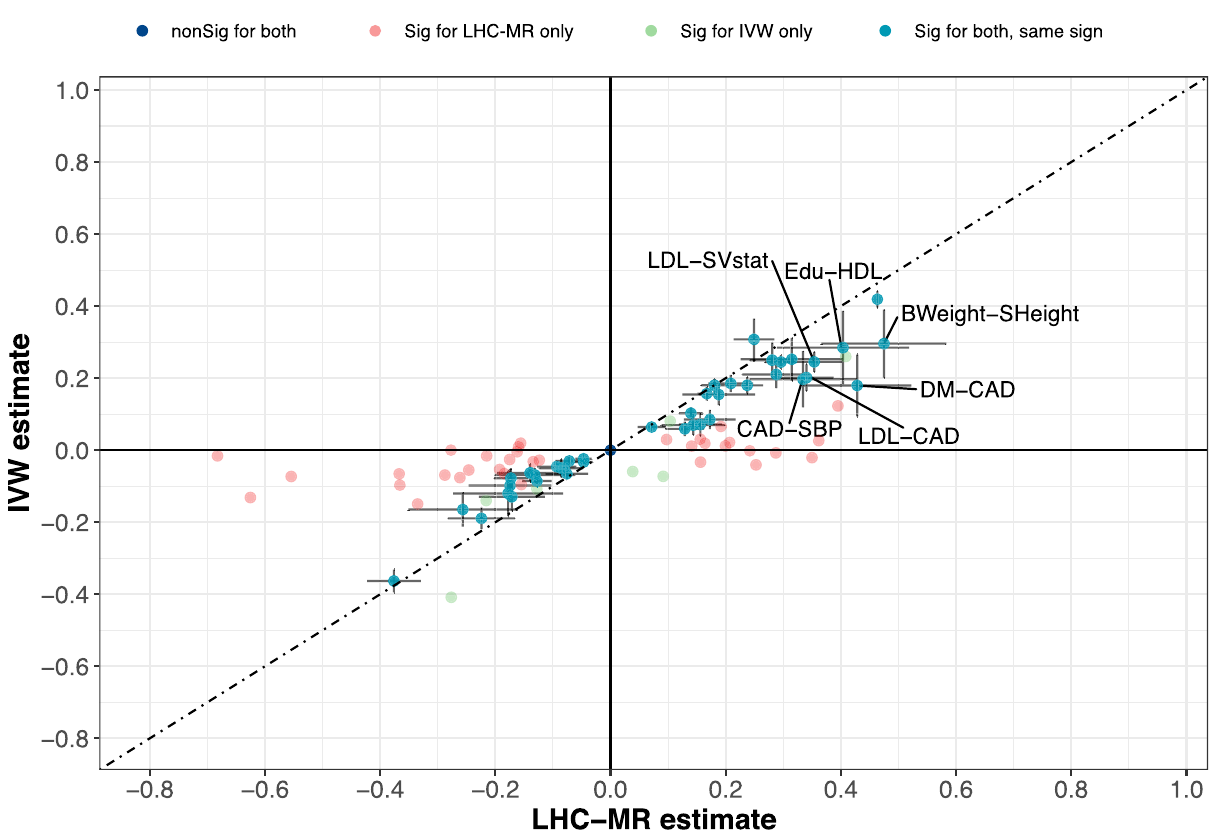
Fig. 5 A scatter plot of the causal effect estimates between LHC-MR and IVW. To improve visibility, non-signi fi cant estimates by both methods are placed at the origin, while signi fi cant causal estimates by both methods appear on the diagonal with 95% CI error bars. Pairs with an absolute value difference > 0.1 are